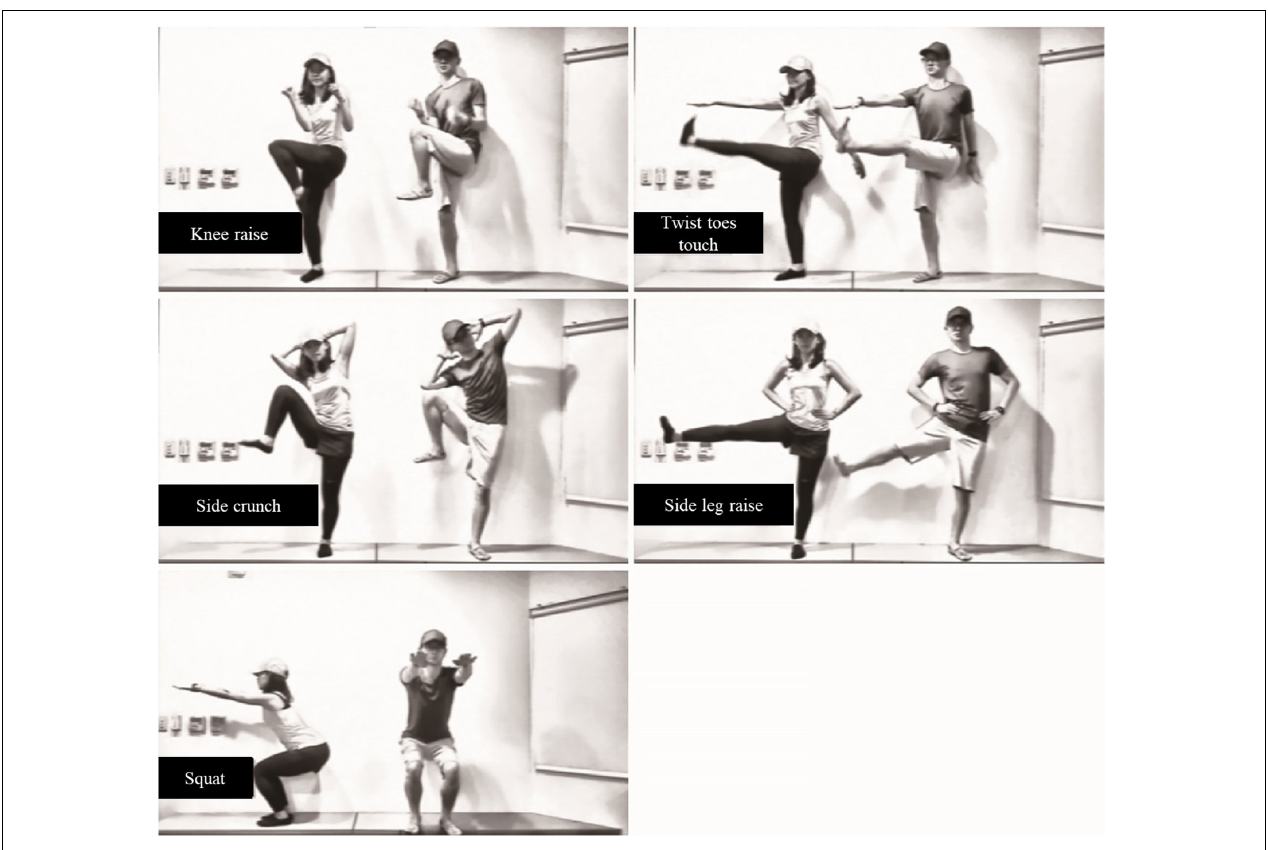
FIGURE 4 | The standing core workouts in the